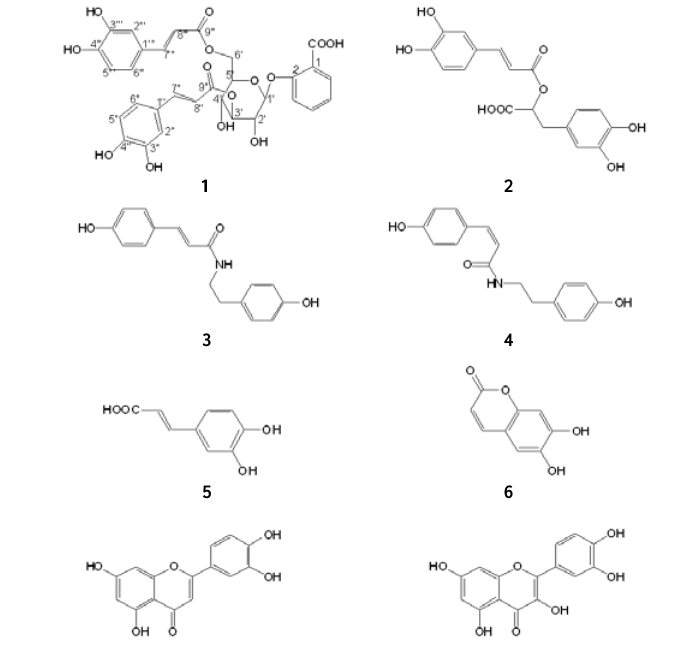
Figure 1. Phenolic compounds isolated from M. umbellata subsp.